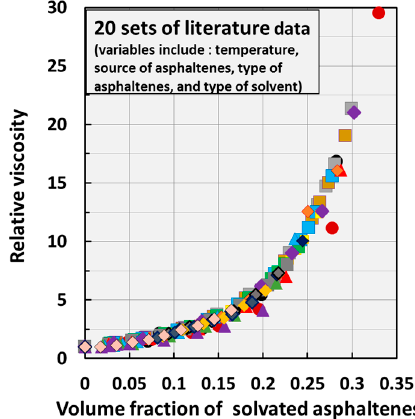
Figure 12. Scaling of relative viscosity of 20 different sets of asphaltene suspensions with respect to φ S , volume fraction of solvated asphaltene nanoaggregates.